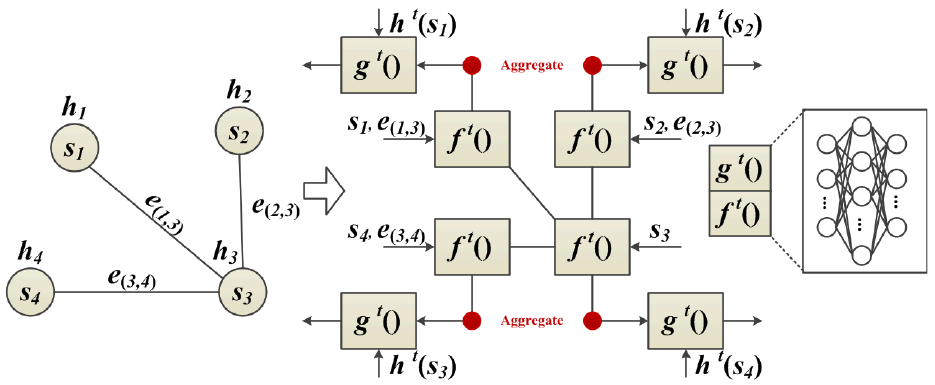
Figure 4. GNN based on neighbor feature alignment mechanism in a single iteration.